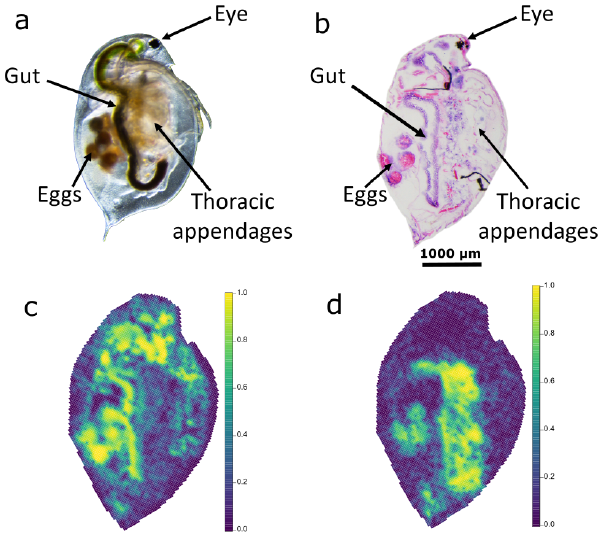
Figure 1. Images of the model organism Daphnia magna ; ( a ) labelled microscope image, ( b ) labelled H&E-stained cryosection that was generated using our optimized tissue preparation workflow, ( c , d ) ion images showing the distribution of phosphatidylcholine ( m/z = 756.5521) and triacylglyceride ( m/z = 835.6229), respectively. The color bars show the relative intensity of the lipid in the ion images.